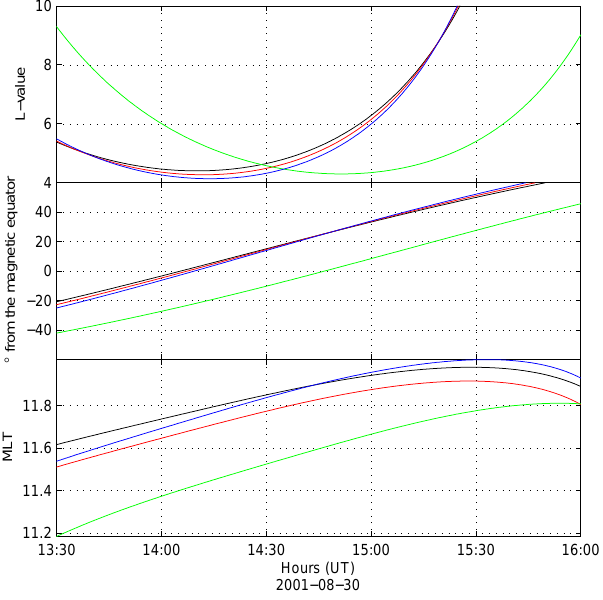
Fig. 3. Solar wind parameters measured by Geotail. The upper panel shows the absolute value of the interplanetary magnetic field. The lower panel shows the solar wind dynamic pressure.